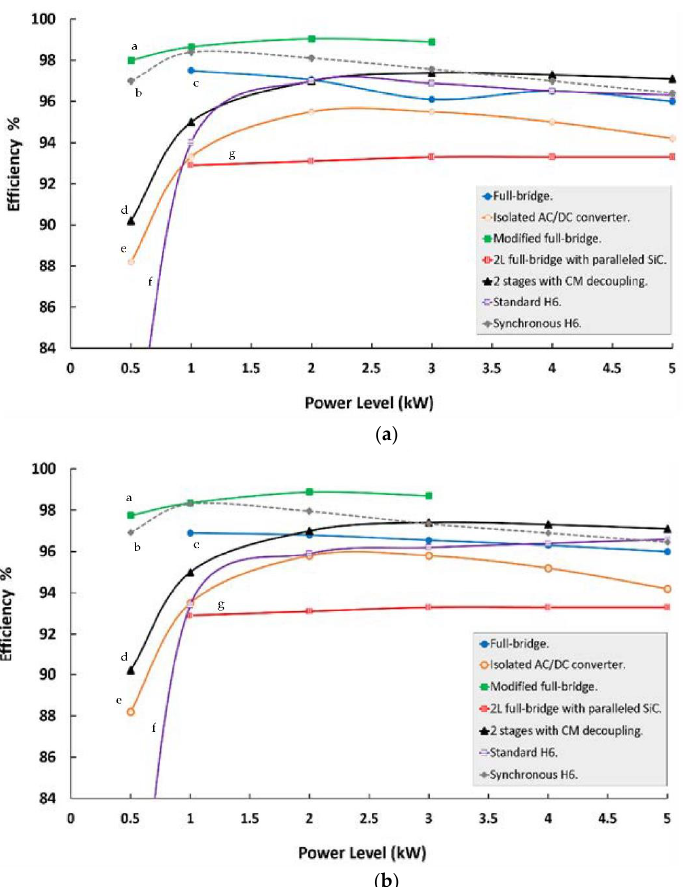
Figure 13. Bidirectional inverter efficiency comparison curves of ( a ) inversion mode, ( b ) rectification mode. a — [43]; b — [54]; c — [52]; d — [57]; e — [51]; f — [53]; g —